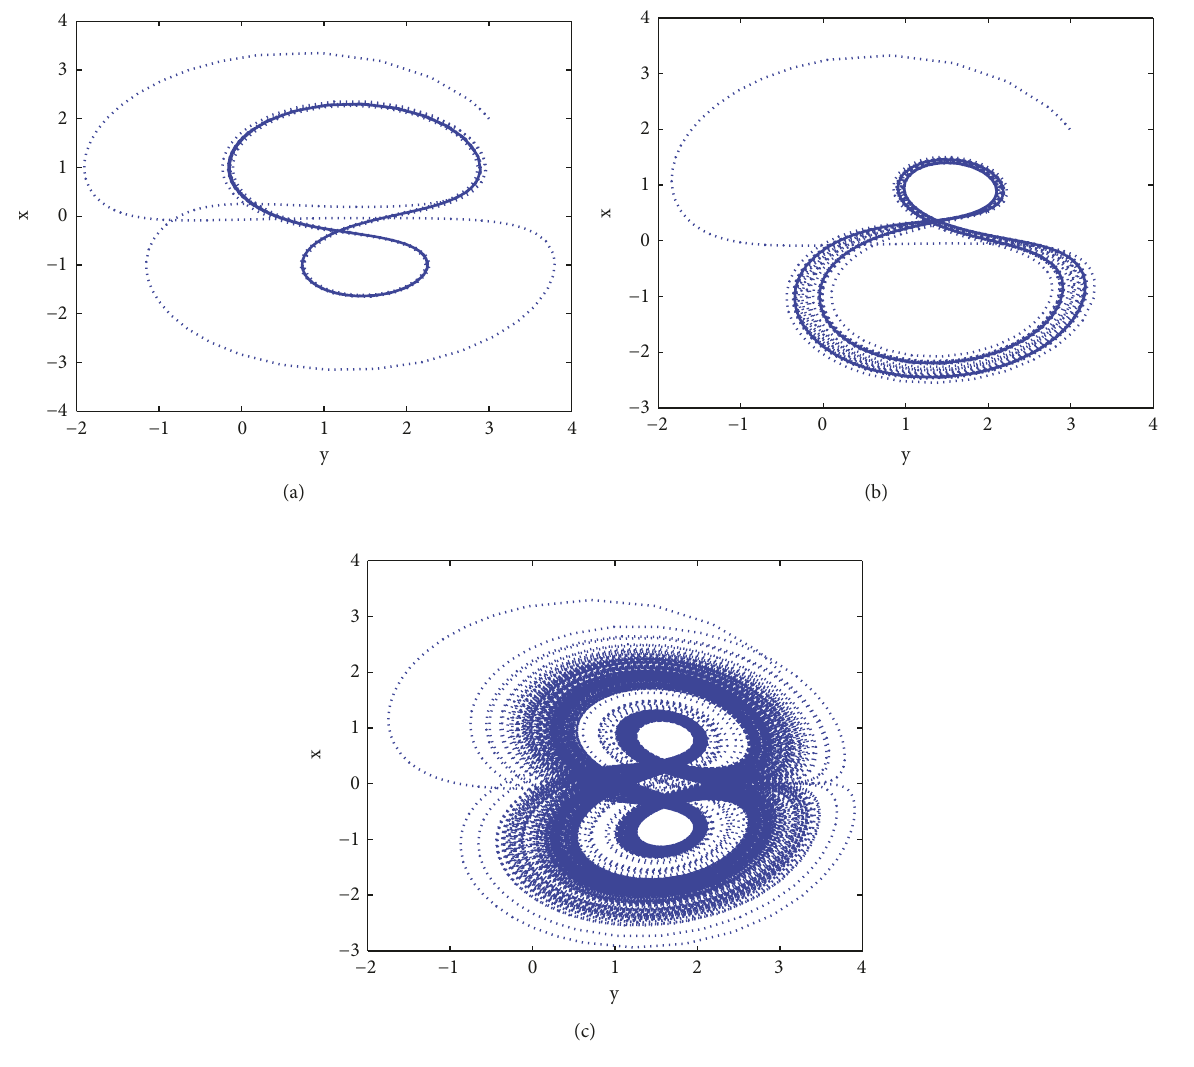
Figure 14: For (a), 𝑏 = 0.01 . For (b), 𝑏 = 0.1 . For (c), 𝑏 = 0.2